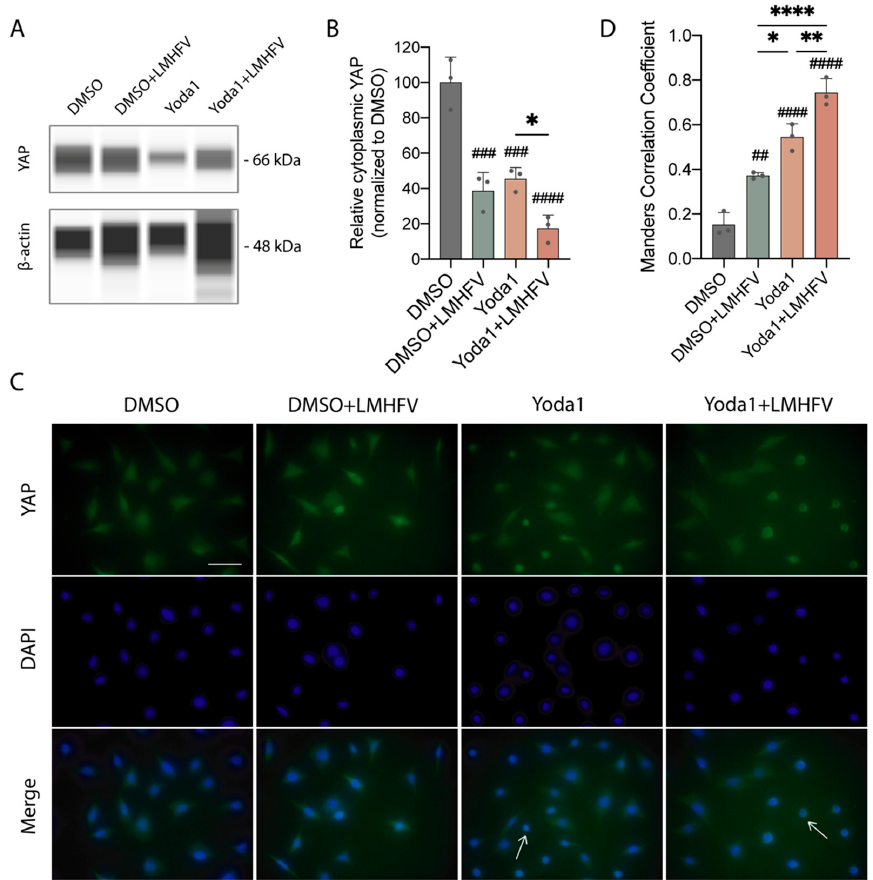
Figure 4. Combined treatment increased YAP nuclear translocation in MLO-Y4. ( A ) Western blot measurement of cytoplasmic YAP expression in MLO-Y4 cells stimulated with DMSO, monotreatments, or combined treatment. ( B ) Quantification of cytoplasmic YAP in cells described in ( A ). Data points represent three technical replicates ( n = 3). ( C ) Immunofluorescent staining for YAP and nuclei (DAPI) in MLO-Y4 cells stimulated with DMSO, monotreatments, or combined treatment. Arrows indicate the representative cells with YAP localized in nucleus. Scale bar = 10 μ m. ( D ) Quantification of YAP nucleus localization in cells described in ( C ) ( n = 3). The incubation duration of Yoda1 in both Yoda1 only and combined treatment groups is 4 h. **** p < 0.0001, ** p < 0.01, * p < 0.05; #### p < 0.0001, ### p < 0.001, ## p < 0.01 in comparison to DMSO control.